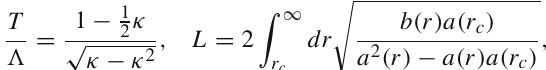
4 Entropic force in N = 4